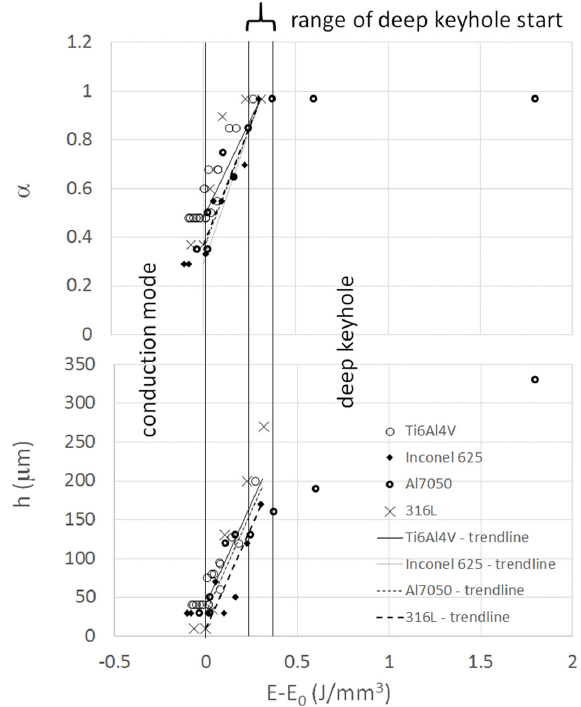
Figure 6. Values of absorptivity α and depth of energy deposition h vs the difference of specific energy and yield value of specific energy between conduction and evaporation. All adjusted values for the alloys: Ti6Al4V, Inconel 625, Al7050 and 316L are included in the diagram. The rising trend of h after deep keyhole formation ( α = 0.97) has been measured for alloys Al7050 and 316L, showing different features. While the Al7050 track depth begins to increase less steeply after a deep keyhole appears, it keeps on following the same slope in 316L tracks. Maybe this could comparable to the track depth at high laser ‐ specific energies.